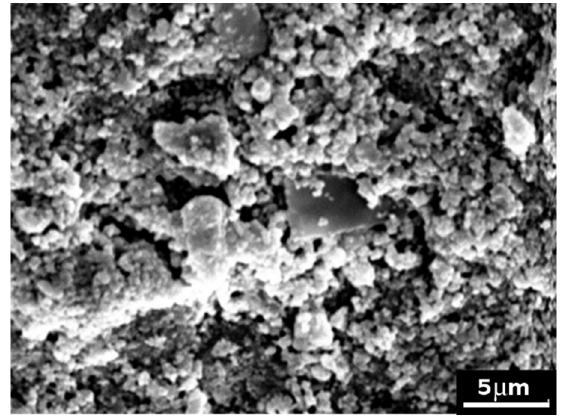
Figure 8. SEM picture (×3500) of model dentin treated with formulation 2 showing various clasts, such as small-medium perfect crystals, several micrometres in size on the surface.